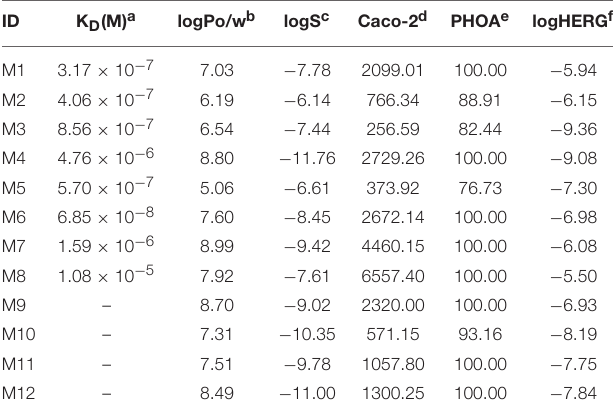
TABLE 2 | Assessment of ADMET properties of the hits by Qikprop.